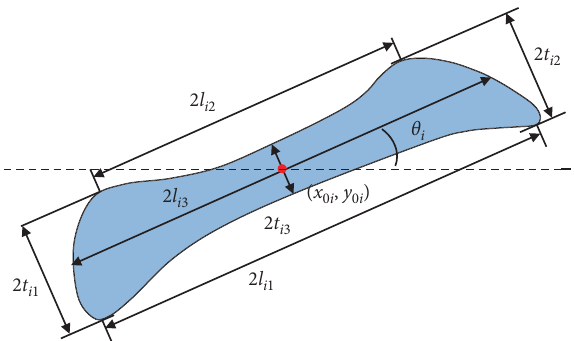
Figure 4: Geometry description of the variability of components’